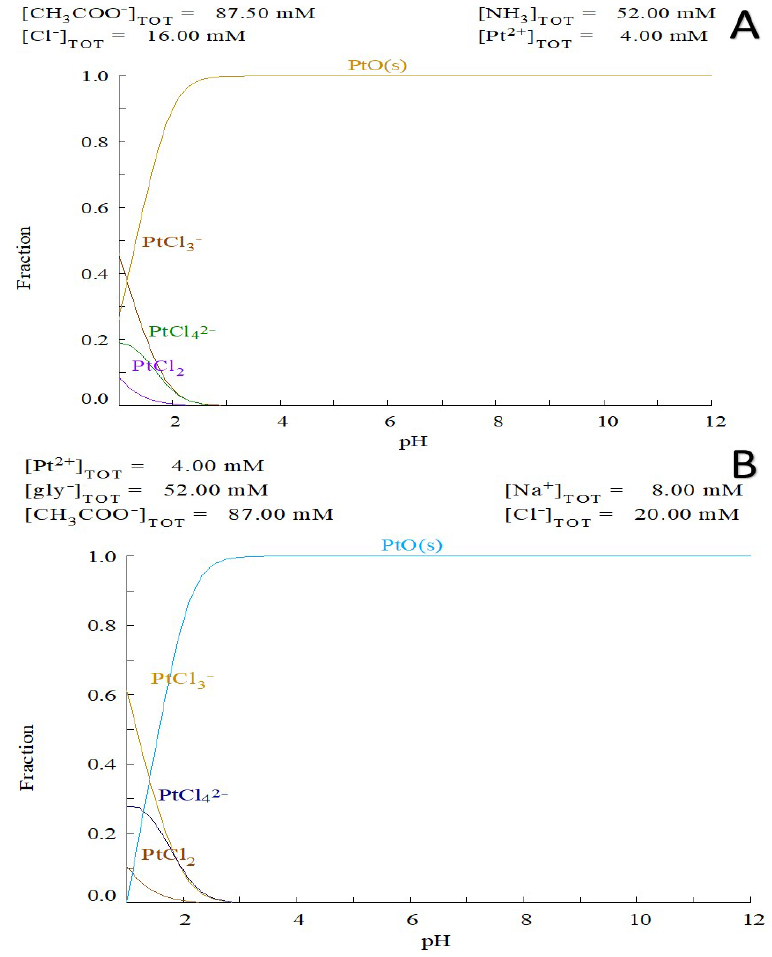
Figure 2. Speciation of Pt ions in reaction mixture : ( A ) 4 mM Pt(II) ions 52 mM ammonia, 87.5 mM of acetic acid and 16mM chloride anion vs. pH; ( B ) 4 mM Pt(II) ions 52 mM glycine, 87 mM of acetic acid and 20 mM chloride anion modeling vs pH(Diagram created by Medusa software).